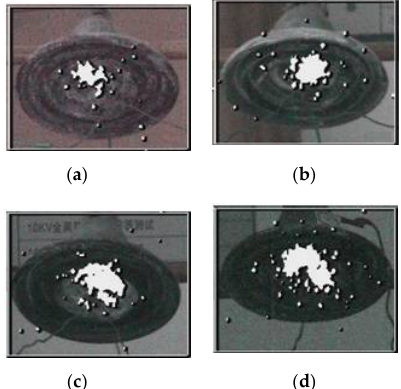
Figure 5. UV images of contaminated insulators in 85% relative humidity: ( a ) contaminated insulator of grade I, ( b ) contaminated insulator of grade II, ( c ) contaminated insulator of grade III, and ( d ) contaminated insulator of grade IV.